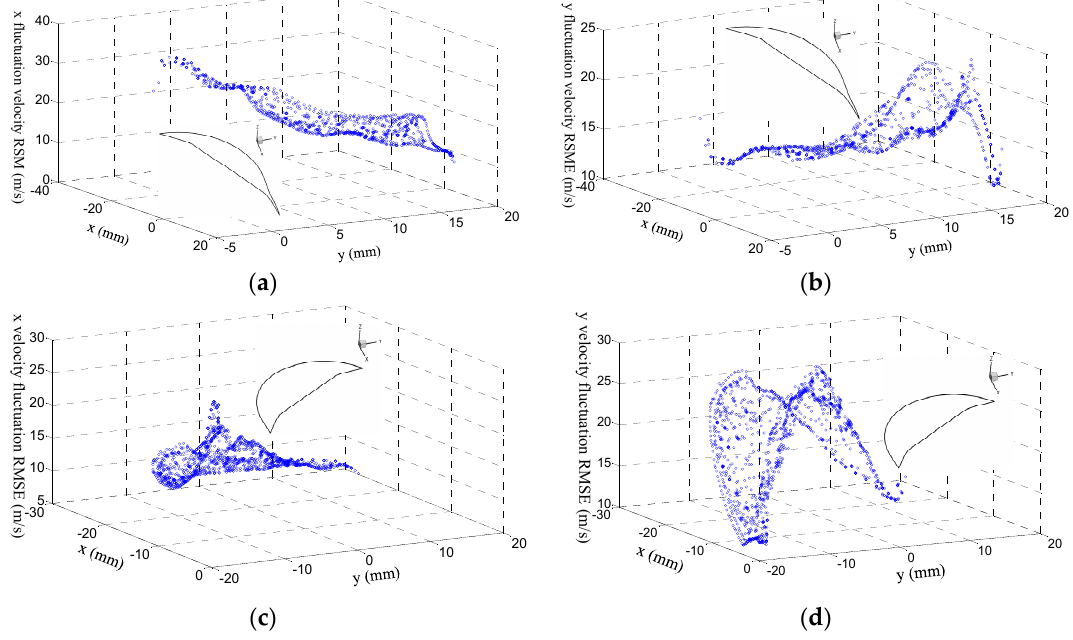
Figure 9. Root-mean-square (RMS) of velocity fluctuation. ( a ) RMS of X velocity fluctuation at 450° BTDC; ( b ) RMS of Y velocity fluctuation at 450° BTDC; ( c ) RMS of X velocity fluctuation at 205° BTDC; ( d ) RMS of Y velocity fluctuation at 205° BTDC.